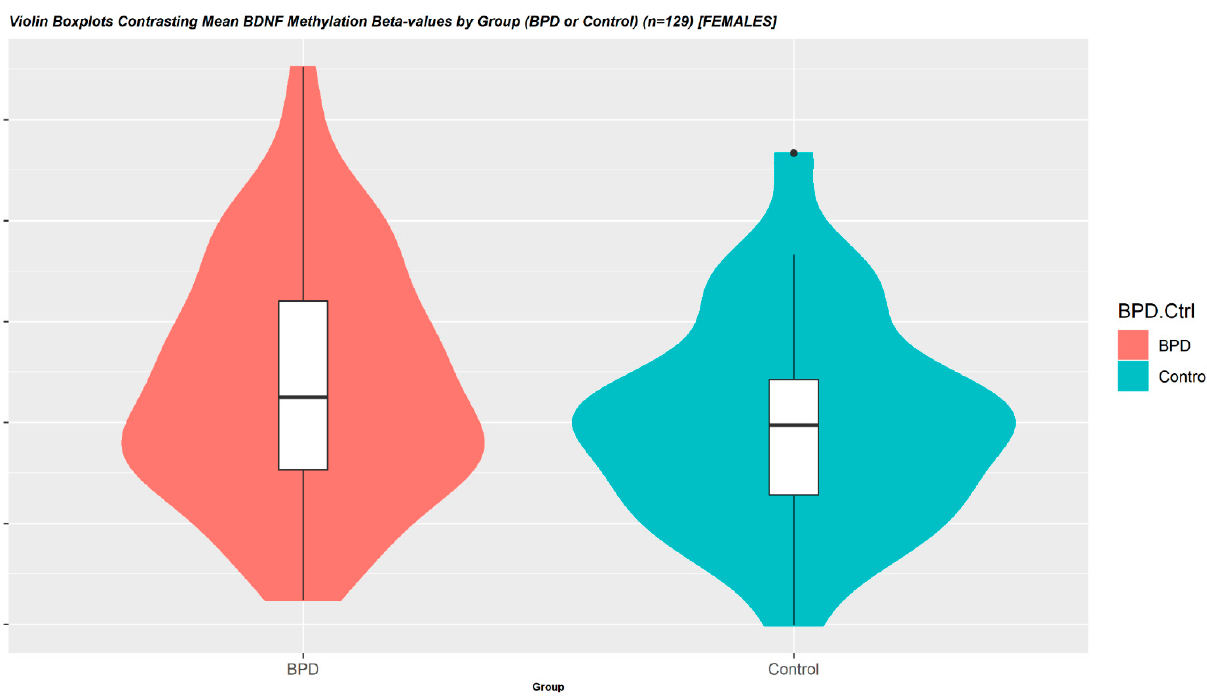
Figure 1. Violin Boxplots Contrasting Mean BDNF Methylation Beta-values by Group (EUPD or Control) (n = 129) [FEMALES]. On the association analysis between whole-blood-derived BDNF - DNA methylation and EUPD, we studied mean values across 16 BDNF -associated promoter CpG-sites. In this analysis—implementing robust linear regression models adjusted for age and BMI—mean BDNF DNA-methylation was increased with dependence on EUPD (compared to controls) ( p = 0.0159). Across all samples, non-M-transformed mean BDNF methylation beta-values were 0.056 (SD = 0.00595) with a mean between-group difference of ~3.8%.